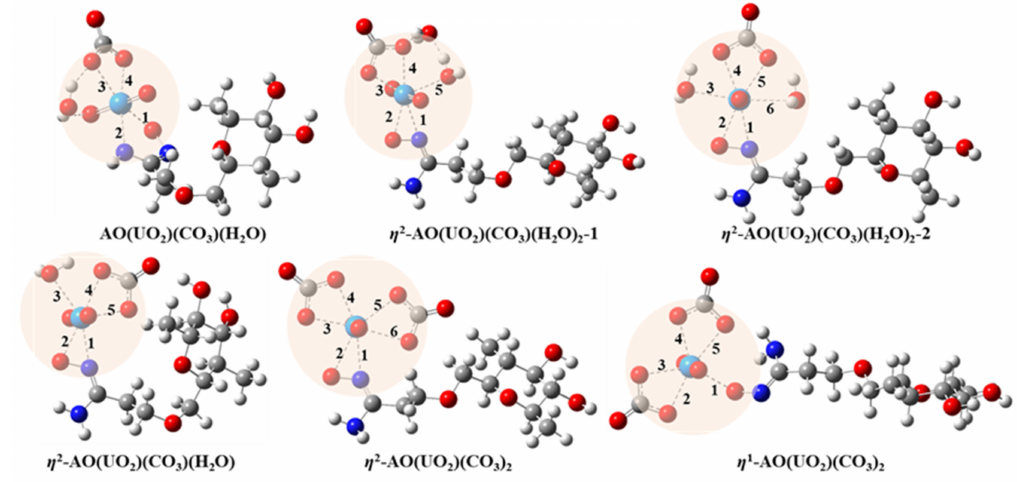
Figure 6. Six models obtained via density functional theory